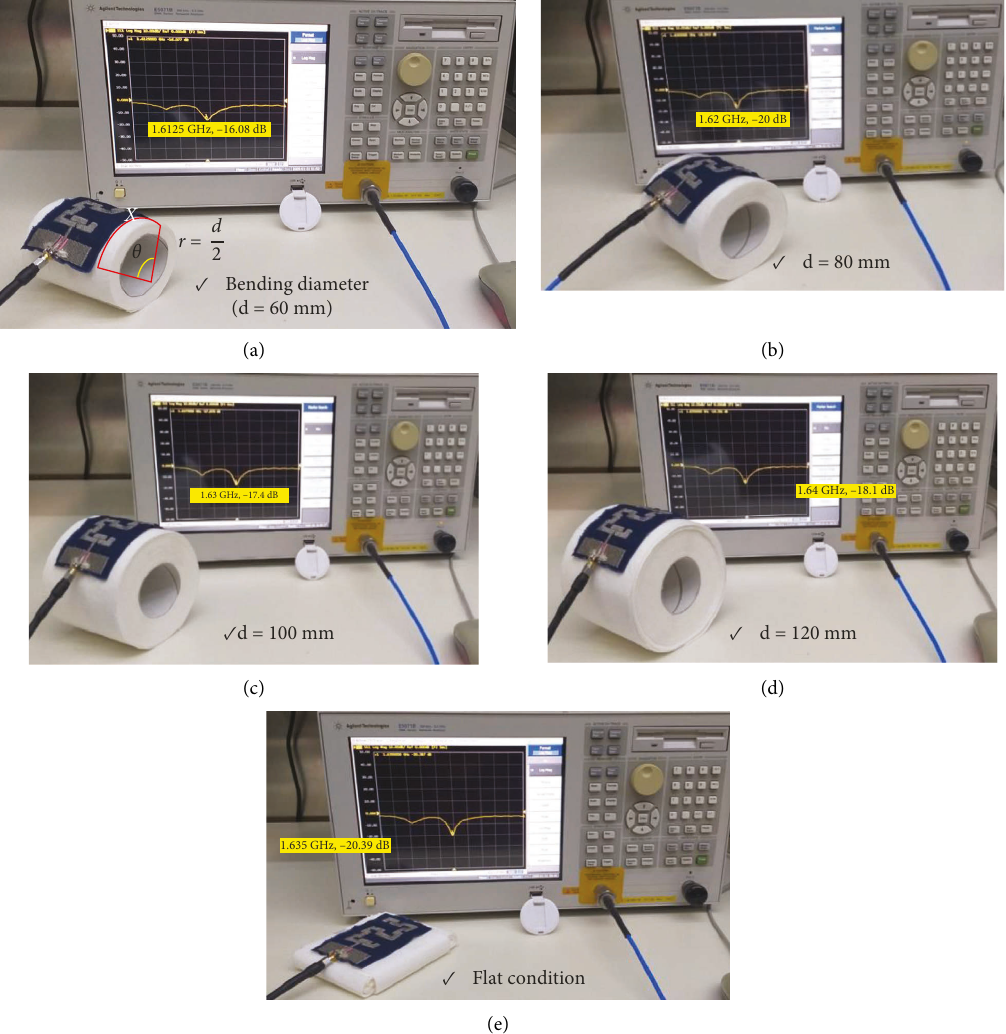
Figure 8: Snapshot of measurement setup under different bending angles of the fabricated antenna; (a) bending angle, θ � 162 . 34 ° , (b) θ � 121 . 75 ° , (c) θ � 97 . 40 ° , (d) θ � 81 . 17 ° , and (e) θ � 0 . 00 °